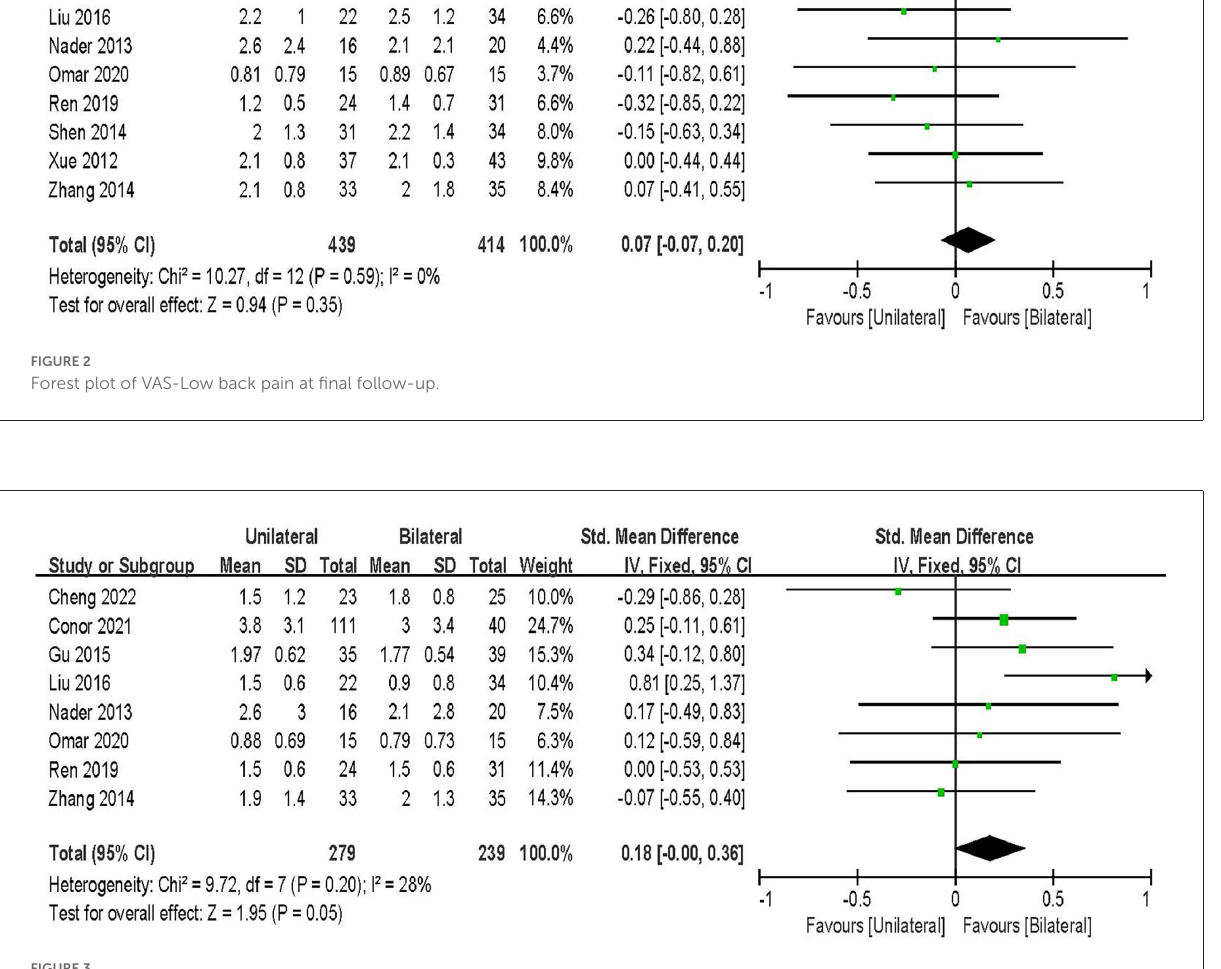
of the vertebral bodies and thus improves the fusion rate. This modification is consistent with the findings of the previous meta-analysis study (36). The same is true for the changes in ODI results. Although the ODI function of both UPSF and BPSF was significantly improved, after BPSF, the ODI score was lower, and the degree of lumbar spine dysfunction was lower than that of UPSF. Therefore, for the selection of the fixation method, if the above factors are considered, BPSF is more likely to be